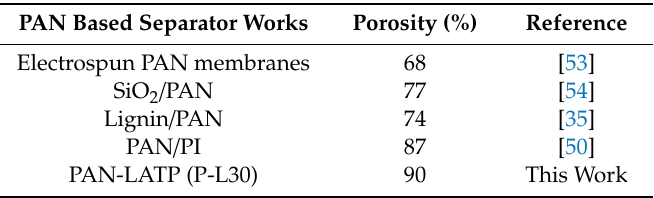
Table 2. Porosity of PAN-based